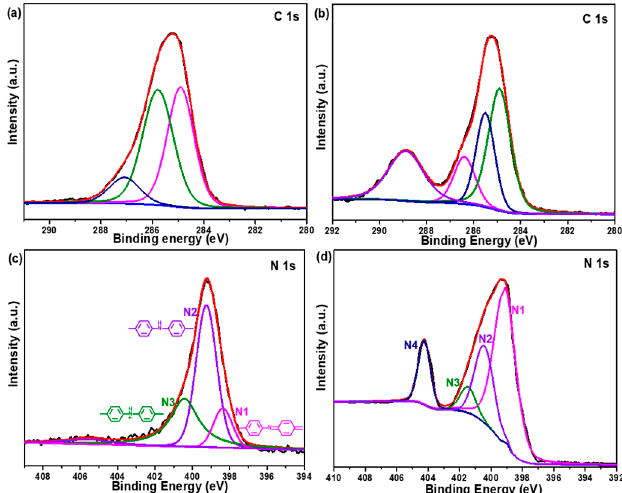
Figure 11. C 1s and N 1s spectra of ( a , c ) pristine CoAl LDH-PANI and ( b , d ) CoAl LDH-PANI obtained by 6000 GCD cycles.